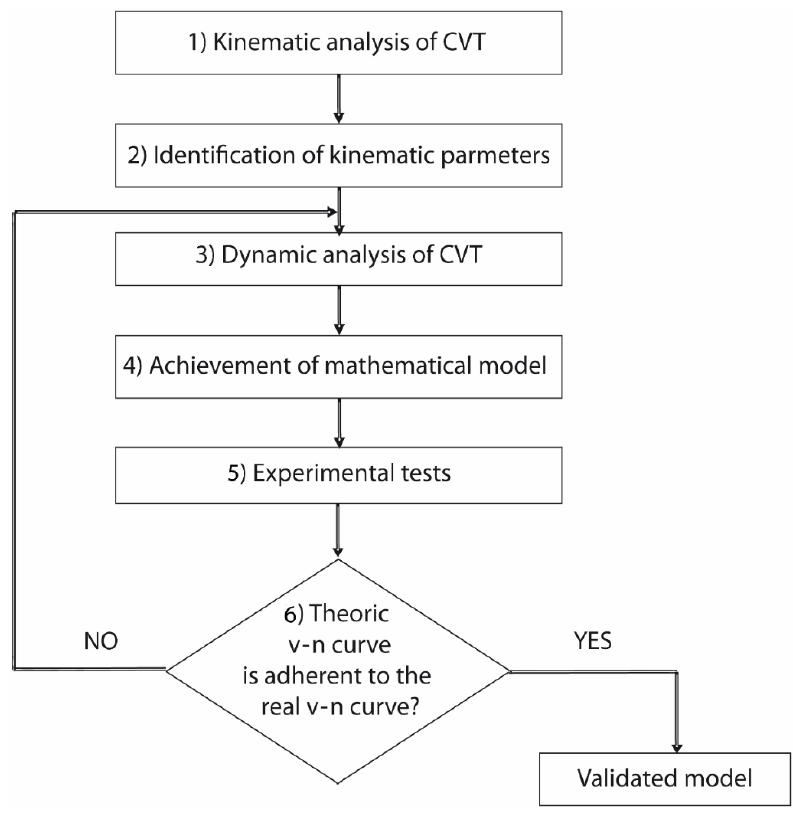
Figure 7. The development path of the mathematical model for the roller curve design.